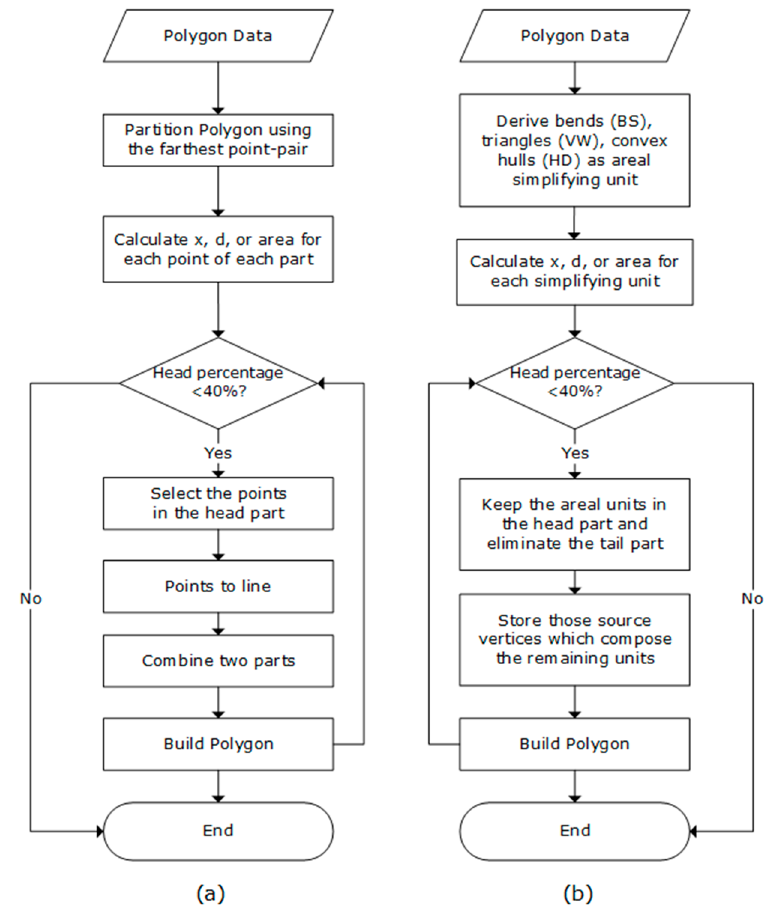
Figure 5. Flow chart for conducting polygon simplification based on head/tail breaks for each algorithm.